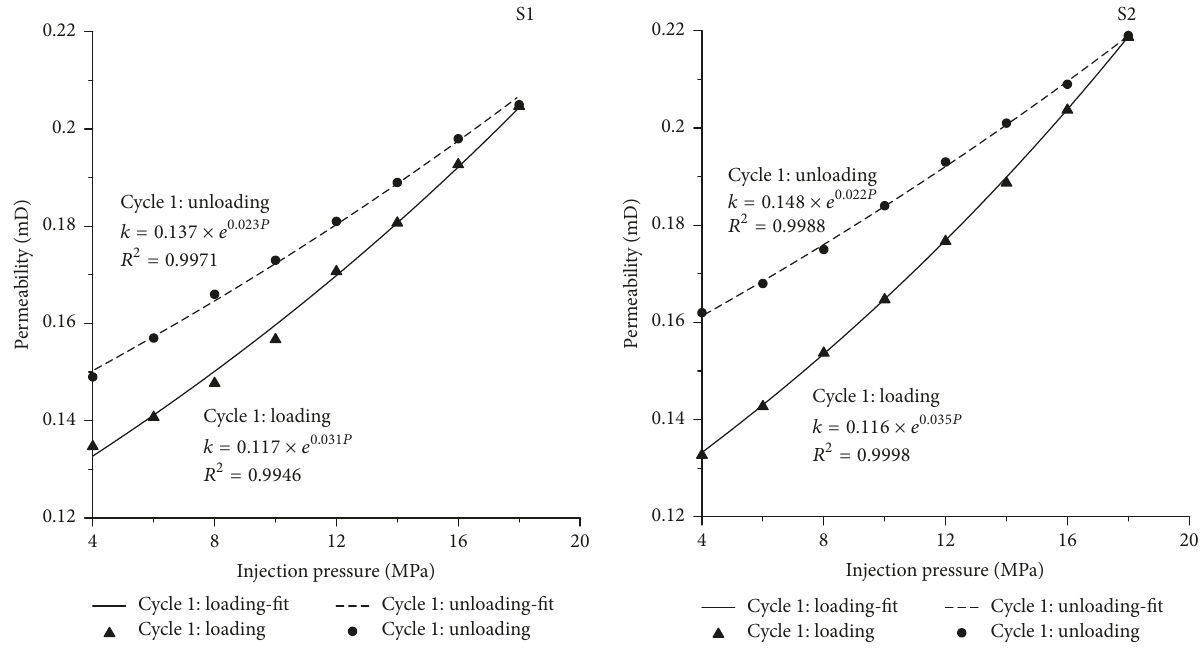
Figure 6: Fitting curves and mathematical models describing the relationship between the permeability and the injection pressure for the first cycle